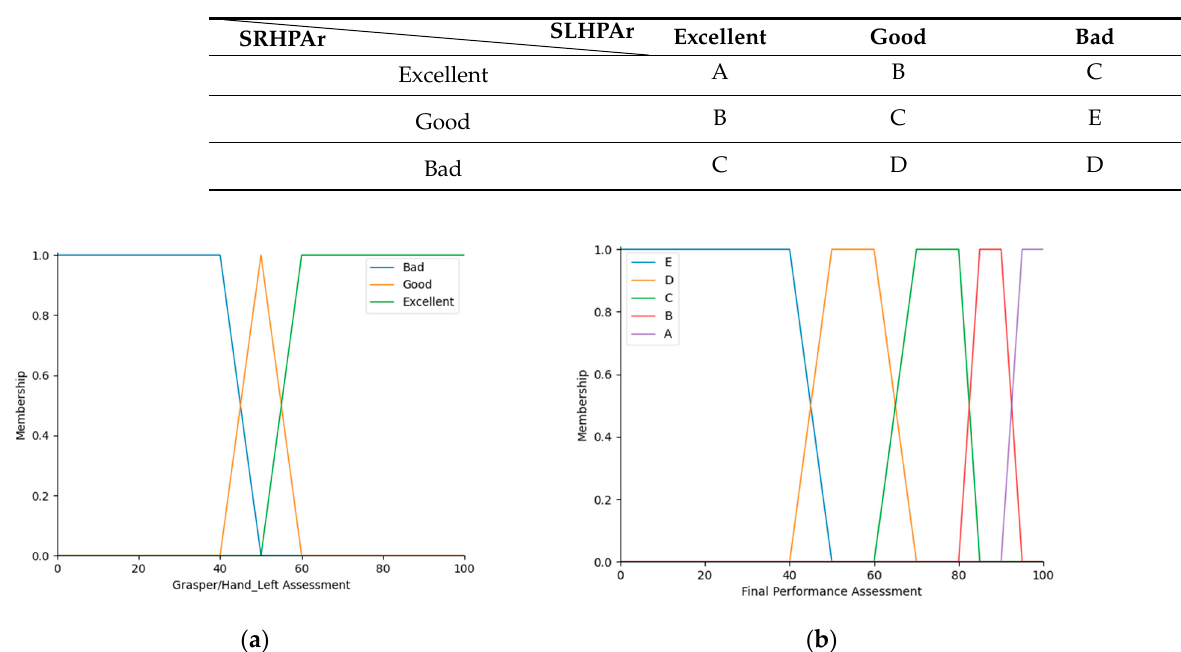
Figure 8. ( a ) MFs of input variables SRHPAr and SLHPAr, in the second level of the fuzzy logic evaluation system. ( b ) Membership functions of the output variable FPA in the second level.